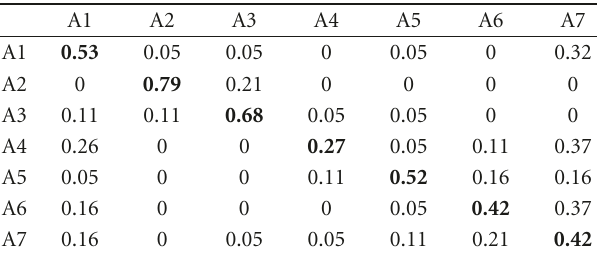
Table 6: Confusion matrix at resolution level 1.